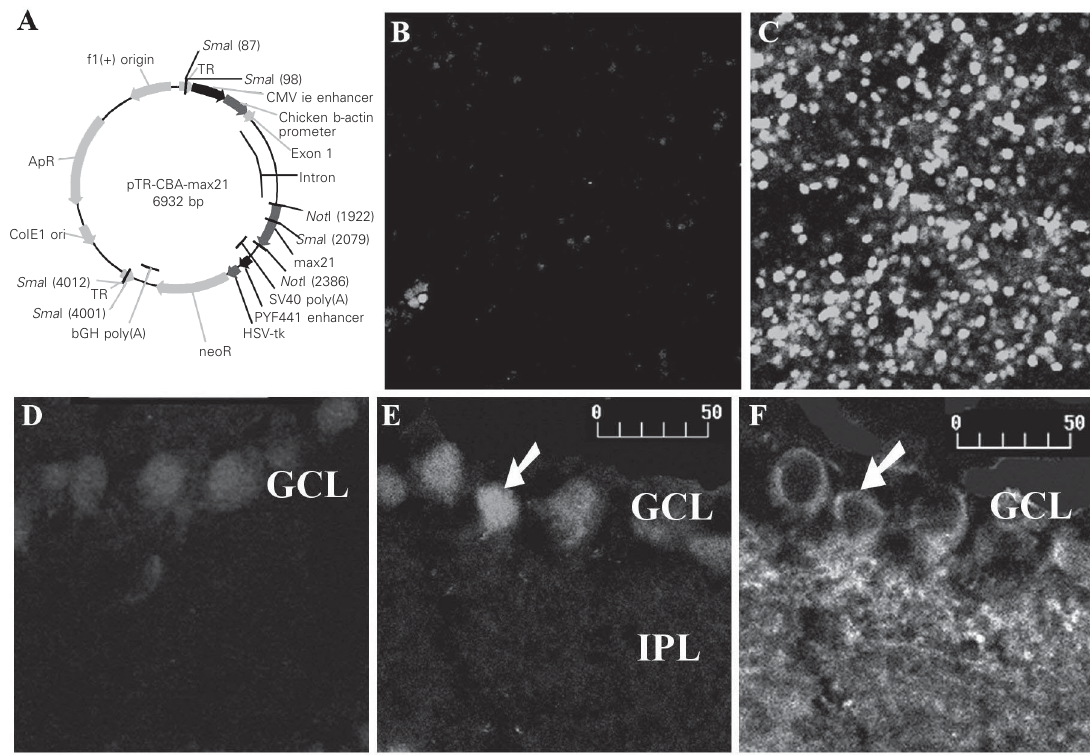
Figure 1. A , Map of the recombinant adeno-associated viral (rAAV)- max vector. f1(+) = origin; f1 = bacteriophage origin of replication; TR = terminal repeats; CMV ie enhancer = cytomegalovirus immediate early enhancer; max21 = coding sequence of the human max gene; SV40 poly(A) = transgene polyadenylation site from Simian virus 40; neoR = coding sequence of the neomycin resistance gene; PYF441 enhancer = enhancer from polyoma virus; bGH poly(A) = bovine growth hormone polyadenylation signal; HSV-tk = thymidine kinase promoter of herpesvirus; ColE1 ori = E. coli origin of replication; ApR, ampicillin resistance sequence. B,C , Test of transfection efficiency. Samples of HEK-293 cells, either uninfected (B), or at 96 h after infection with 2 x 10 13 particles/ml (C), were immunostained with anti-Max antibody (Santa Cruz). Notice the overexpression of Max protein after rAAV- max infection. D-F , Immunohistochemistry for Max (D,E) or for ßIII-tubulin (F) in retinal sections 2 weeks after intravitreal injection of either PBS (D) or rAAV-max (E,F). Notice the overexpression of Max in ßIII-tubulin-immunoreactive retinal ganglion cells (arrows) in the matching E and F photomicrographs. Retinal layers: GCL = ganglion cell layer; IPL = inner plexiform layer. Scale = 50